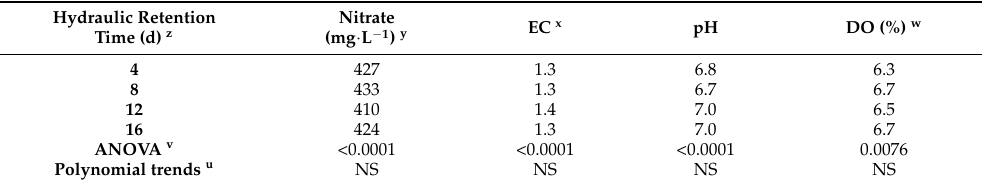
Table 3. Water measurements of HRT interval treatments without iron supplementation. Measure- ments were taken four times per week during the trial from nutrient reservoirs.